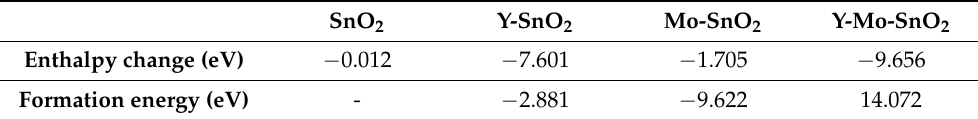
Table 3. Enthalpy change and impurity formation